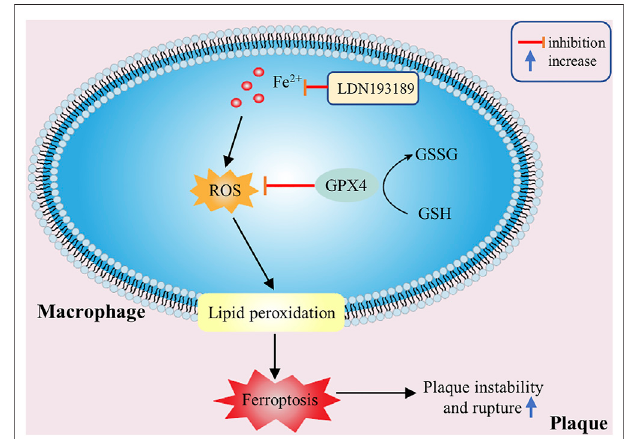
FIGURE 4 | The effectiveness of macrophage ferroptosis on atherosclerosis. Excessive ROS accumulation or iron overload in macrophages can promote lipid peroxidation and other pathological processes, then cause macrophage ferroptosis and increase plaque